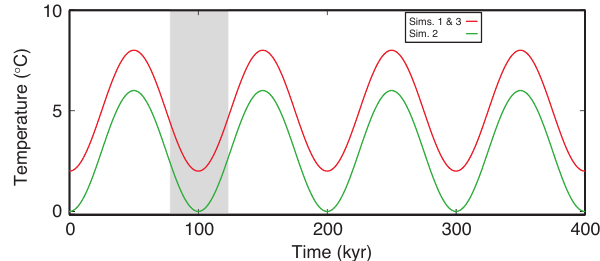
Figure 3. Climate variations over time for the different simulations. Over three complete glaciations are simulated. Simulation 3 has the same climate as Simulation 1 and is not specifically shown. The grey box shows the single glaciation used in the analysis presented in Figs. 5, 7, and